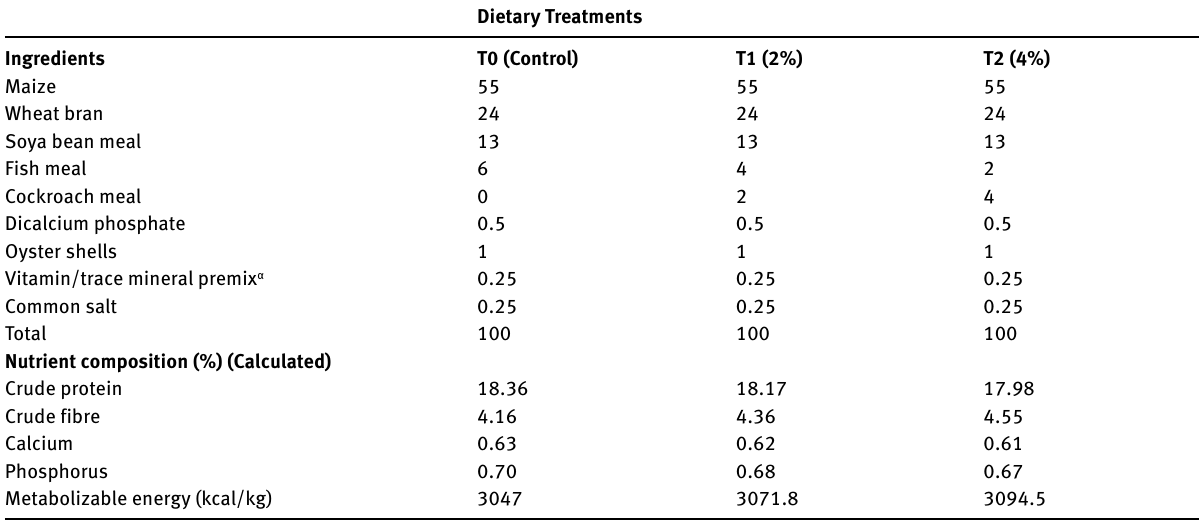
Dietary Treatments